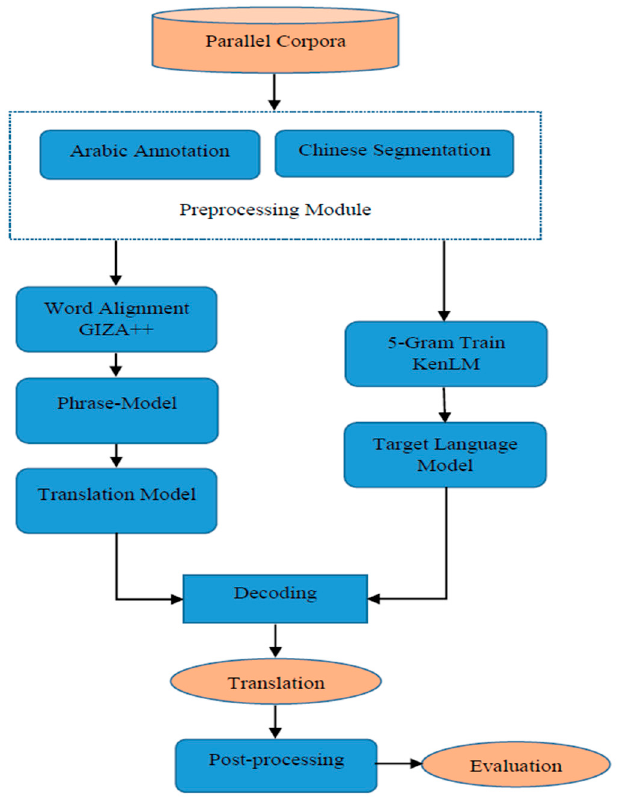
Figure 2. Diagram of the proposed approach.